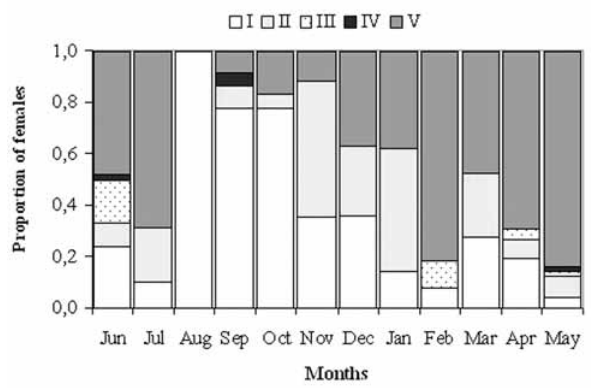
Fig. 7. - Percentage of M. azevia females sampled throughout the year, according to macroscopic maturity stage.